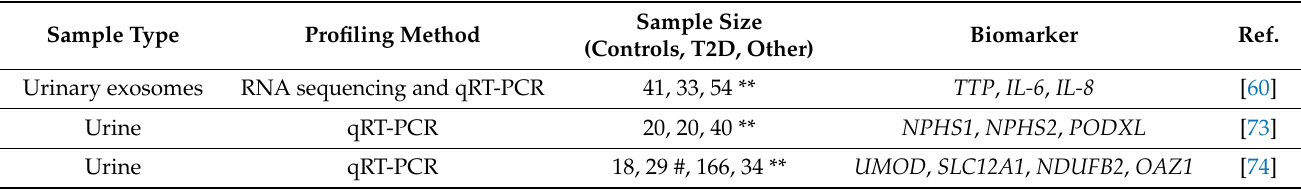
Table 6. Transcriptomics biomarkers from urine samples for